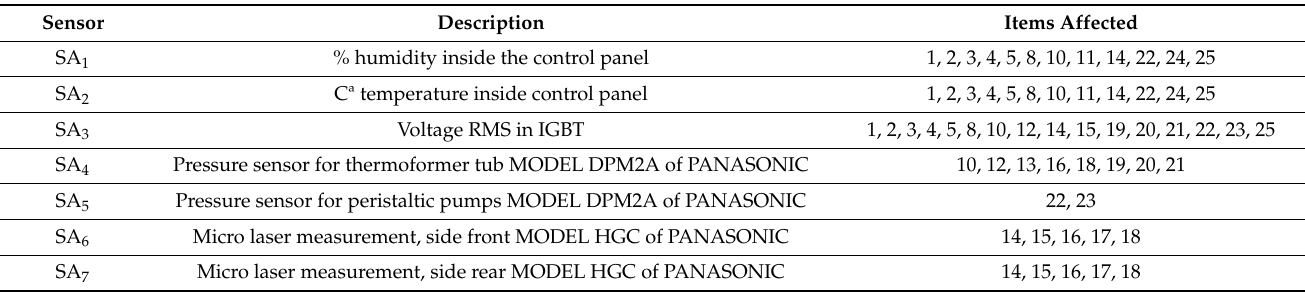
Table 4. Sensors and components used for the ALOP